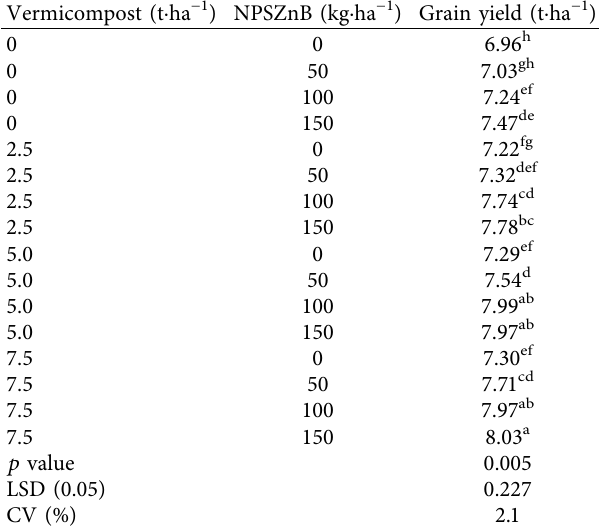
Table 7: Interaction efect of vermicompost levels and inorganic NPSZnB fertilizer on grain yield (t · ha − 1 ) and grain yield increased (%) in Guto Gida, Western